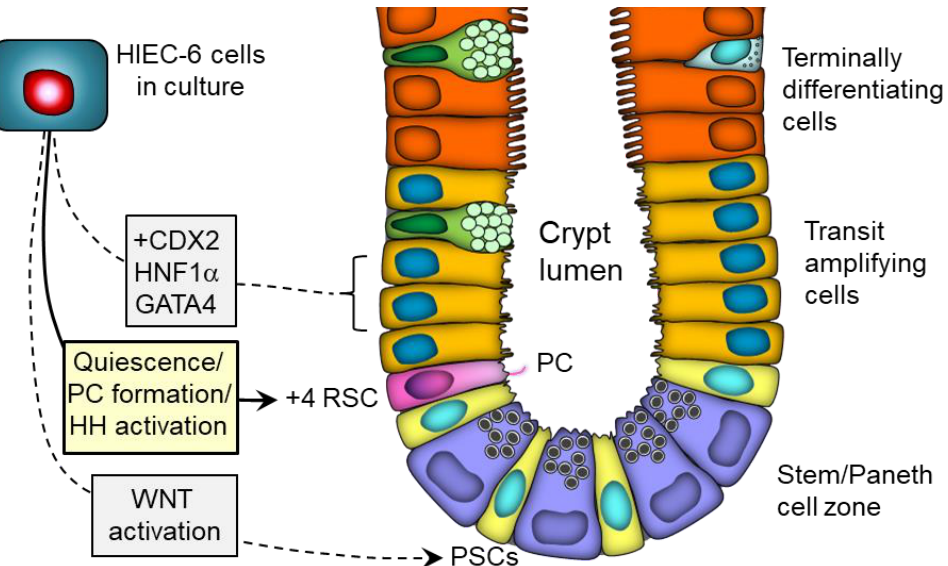
Figure 15. Schematic illustration of the findings of the current study. Primary cilium (PC)-bearing cells (pink) were found in the lower crypt just above the stem/Paneth cell zone at a frequency estimated at one cell per crypt in the human small intestine and corresponding to the +4 reserve stem cells (RSC) described previously. HIEC-6 cells were then used to further investigate the expression of the PC and signaling. HIEC-6 cells were previously found to be unique in their abilities to undertake a differentiation program under the influence of pro-differentiation transcription factors, such as CDX2 and HNF1 α [51,83], as well as to be induced to adopt a primordial stem cell (PSC) phenotype upon activation of the WNT pathway [38]. Herein, we showed that post-confluent HIEC-6 cells express a PC when becoming quiescent and that this PC mediates the activation of the HH pathway, which in turn appears to regulate the cell cycle.